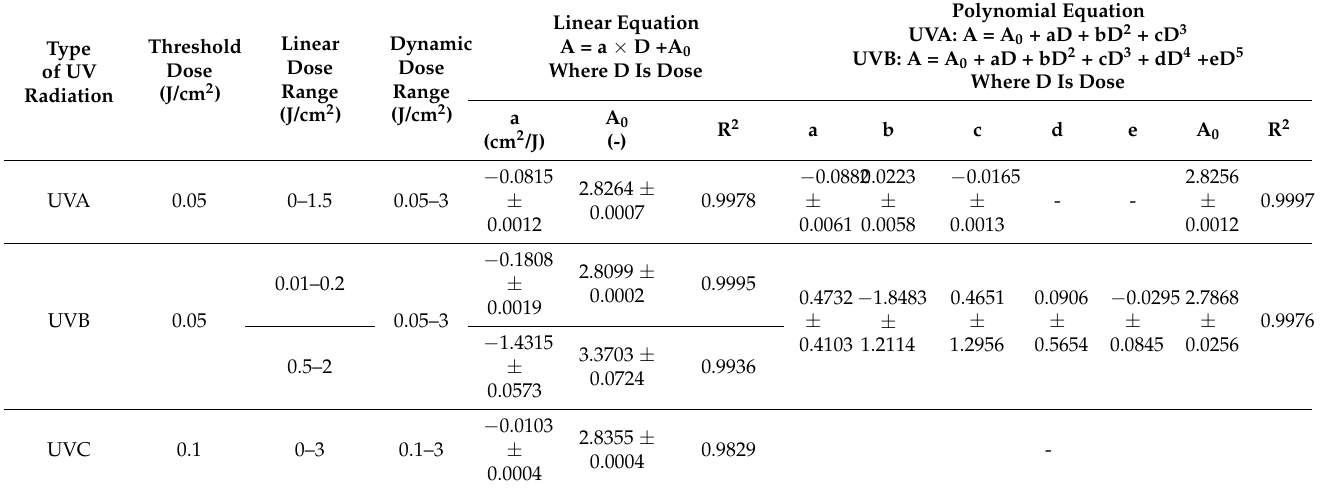
Table 3. Basic parameters of TBO–Pluronic F–127 dosimeter (60 µ M TBO, 5% H 2 O 2 , 25% Pluronic F–127) irradiated with UVA, UVB and UVC radiation, derived from the dose–responses (Figure 4). The linear equation is for the linear (for samples irradiated with UVA, UVB, UVC) and dynamic (for samples irradiated with UVC) dose range, whereas the polynomial equation is for the dynamic dose range of samples irradiated with UVA and